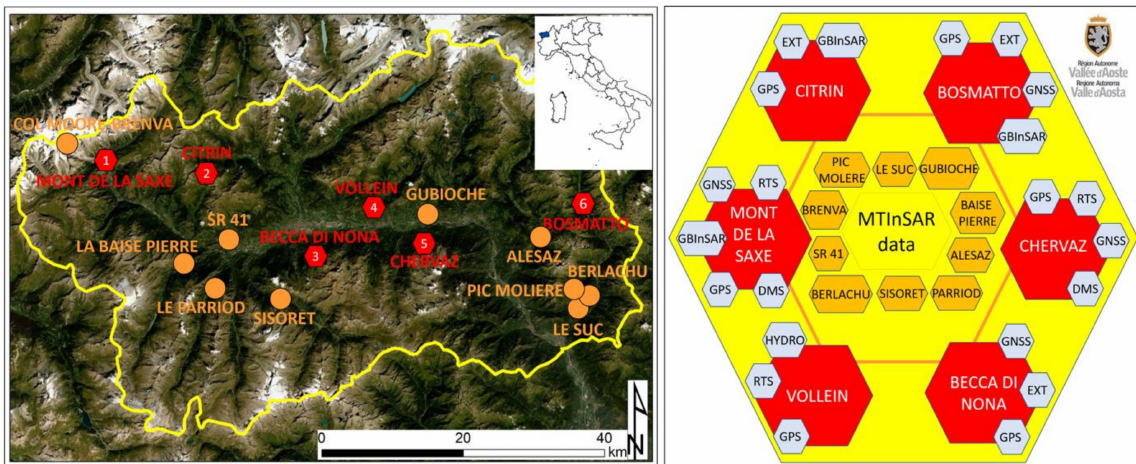
Figure 1. Locations of the landslide cases currently monitored in the Valle D’Aosta Region (VAR), colored according to the levels shown in Figure 1 ( Left ).Setting of the monitoring network in VARCP according to levels shown in Figure 1 ( Right